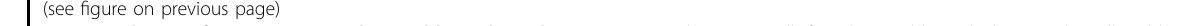
Fig. 3 Landscape of transcriptome in human blastoids on day 6. a A UMAP plot 10,933 cells from human blastoids showing the cells in blastoids were divided into 4 major clusters on day 6. EPI/ICM, PE, TE, and IM (intermediate) subgroups were determined according to the lineage-speci fi c markers. The cells in IM subgroups express all three lineages markers or some uncertain genes. b Heat map of lineage signature genes expression on day 6. c UMAP projection of integrated datasets showing EPI-, PE-, and TE-like cells (and IM clusters) together with EPI, PE, and TE cells of blastocysts from a previous published study 7 . d Dot plot indicating the markers of EPI, PE, and TE lineage markers. e Overlapping genes expression between a previous study 7 and this study was performed by heat map and GO term